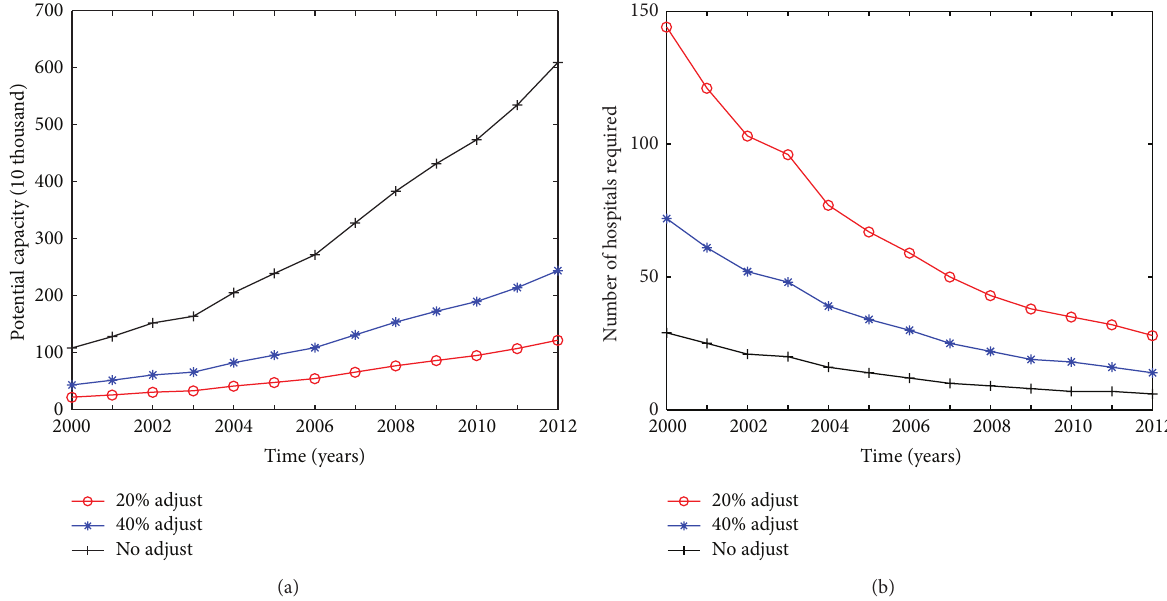
Figure 2: Illustration of the potential capacity and the number of hospital required under different correction coefficients. (a) Potential capacity, and (b) number of hospital required.